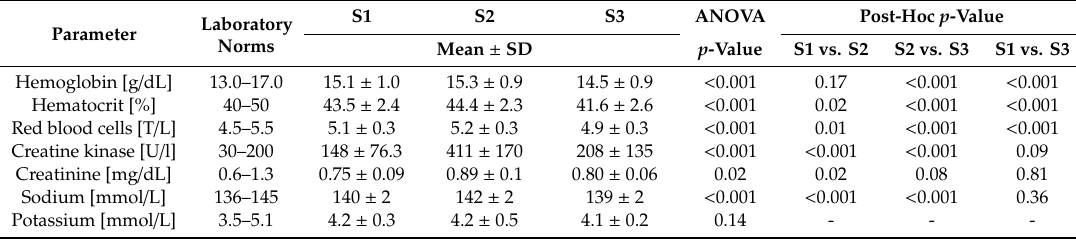
Table 2. Results of biochemical analysis performed 2–3 weeks before the marathon (S1), on the finish line (S2) and 2–3 weeks after the marathon (S3). Parameter